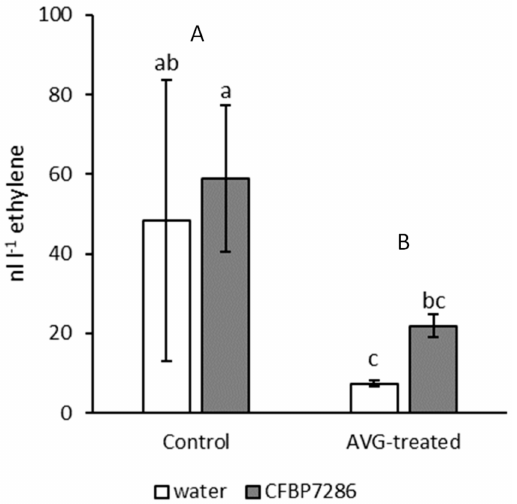
Figure 9. Ethylene emission from Actinidia deliciosa microcuttings, included in 500-mL jars with AVG-containing medium, 1 week after inoculation with Pseudomonas syringae pv. actinidiae strain CFBP7286. Different lower-case letters indicate significant differences (determined by two-way ANOVA followed by Fisher’s least significant difference test with p ≤ 0.05, n = 3) due to interaction between AVG treatment and pathogen inoculation. Upper-case letters refer to single-factor differences between AVG treatment and water.